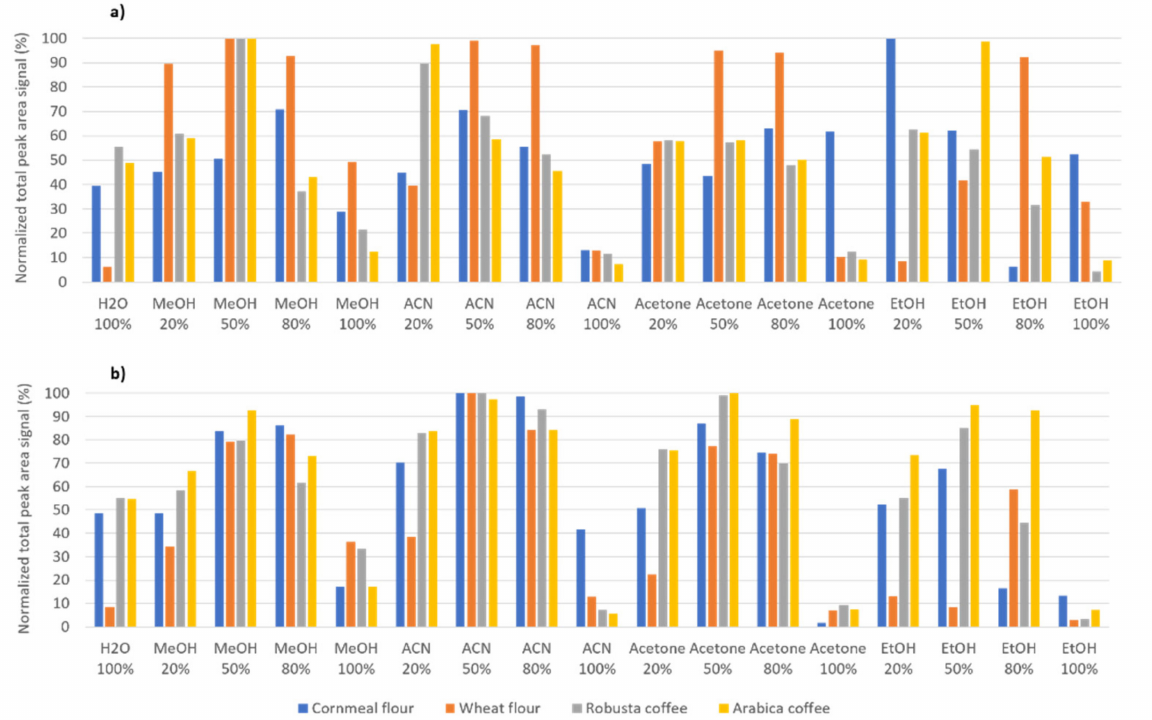
Figure 1. Total peak signal (normalized to the solvent providing the highest signal) of all the chemicals extracted with different extraction solvents and detected by ( a ) high-performance liquid chromatography with ultraviolet (HPLC-UV) and ( b ) HPLC- fluorescence detection (FLD) (within the chromatogram segment from 8 to 40 min) for a Vietnamese Arabica coffee, a Vietnamese Robusta coffee, a cornmeal flour, and a wheat